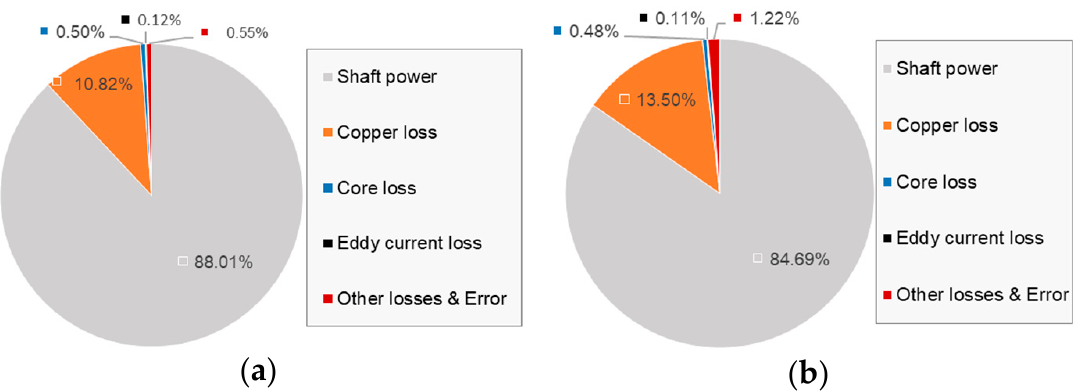
Figure 11. Shaft power and losses for the moving magnet linear motor with a fixed pressure ratio of 2.0 ( a ) a stroke of 9 mm and ( b ) a stroke of 11 mm.